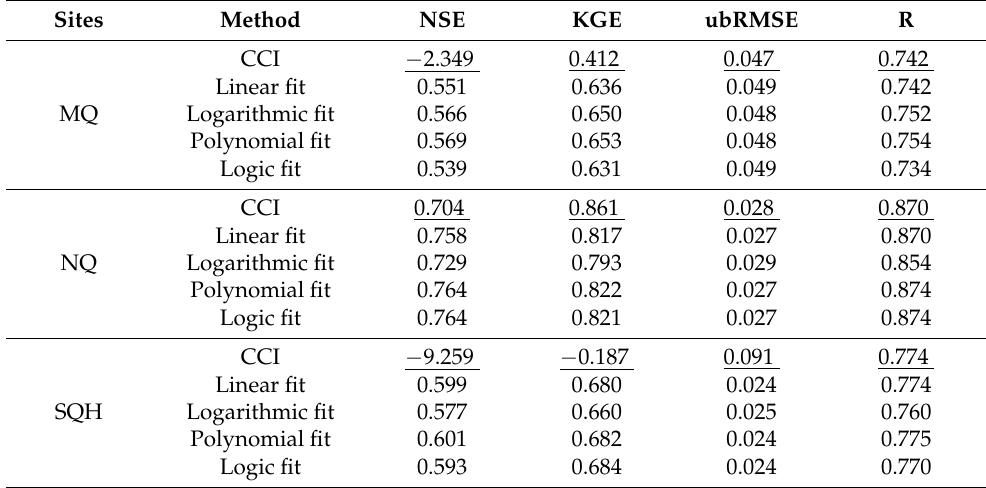
Table 3. Statistical scores of four conventional fitting methods measured between the in-situ observed and the calibrated CCI-C SMC data in the three network areas; the underlined values were calculated from the in-situ observed and the CCI-C SM data prior to